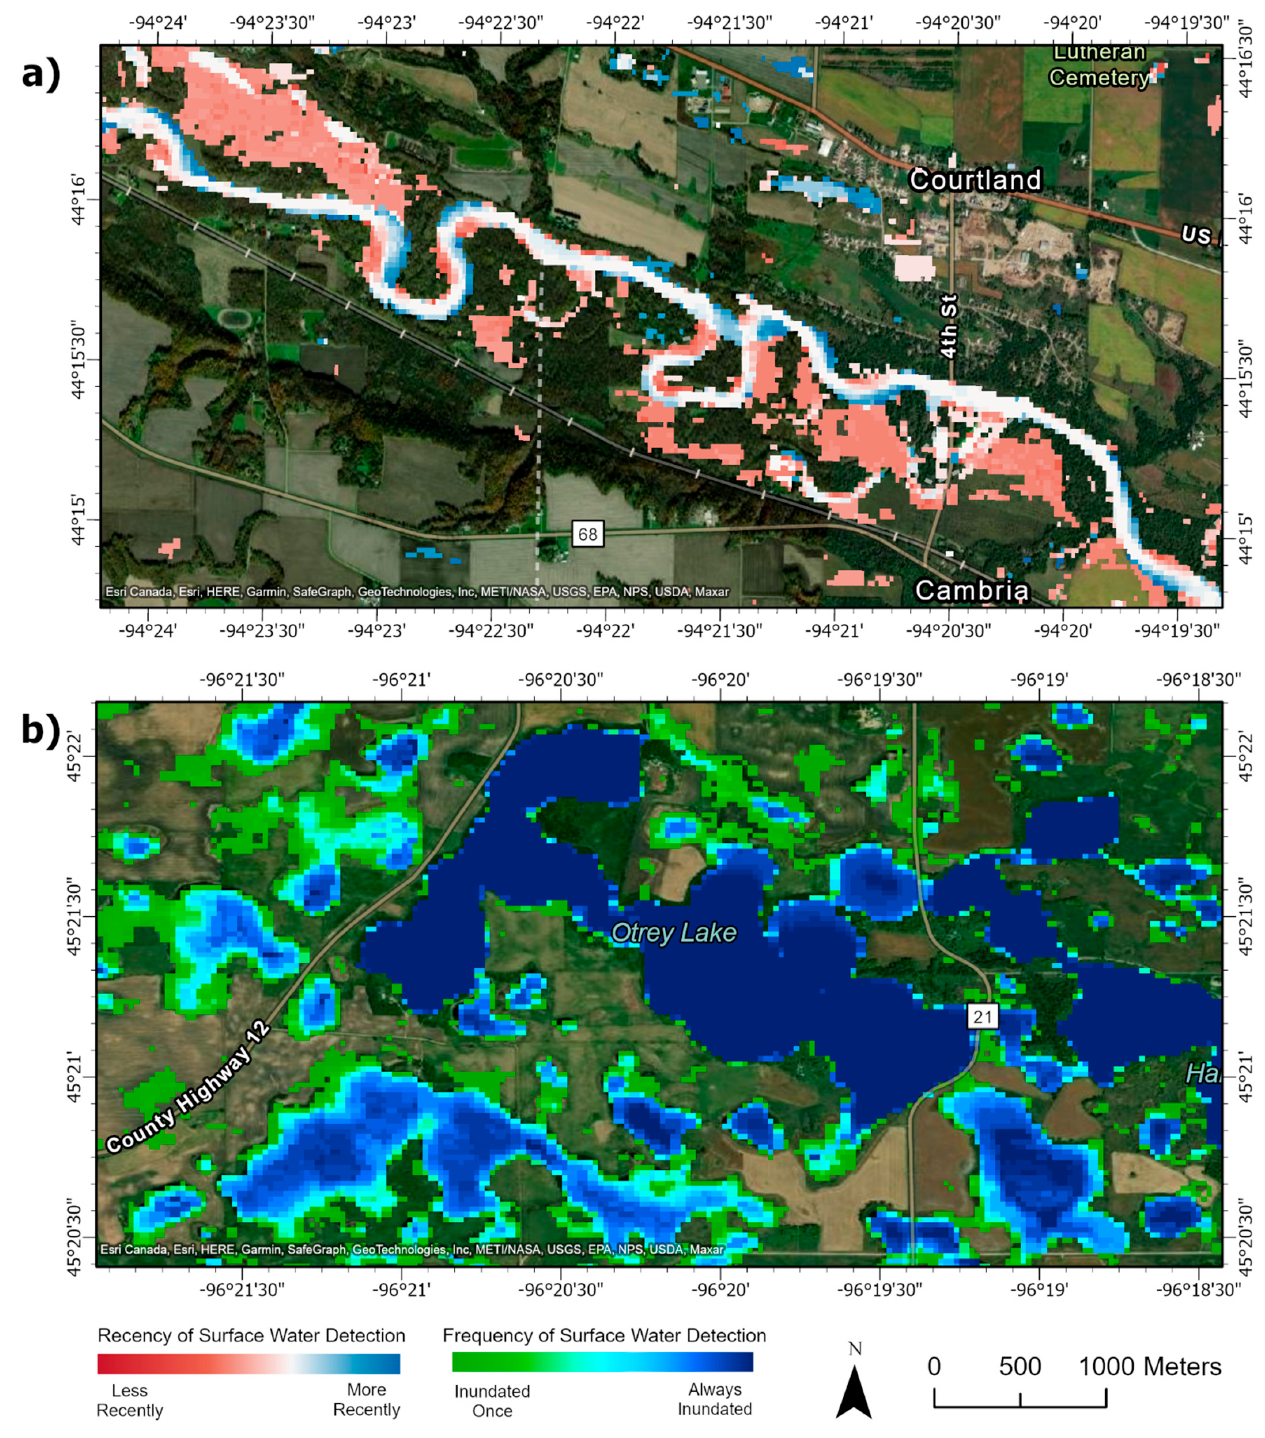
Figure 8. Example multi-pixel aggregations of the LandTrendr result. ( a ) The LandTrendr